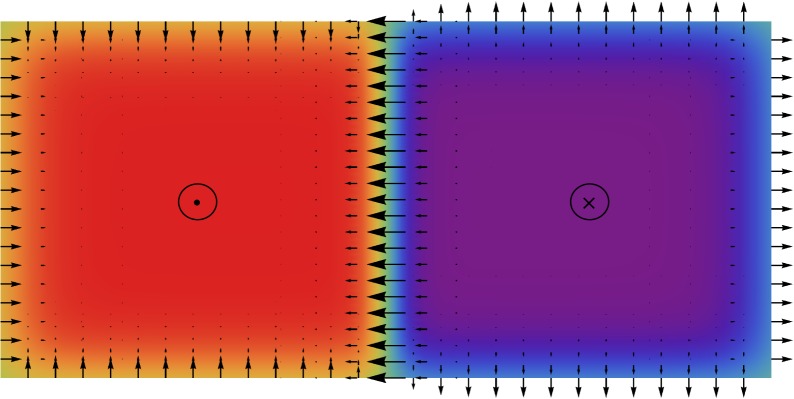
Schematics of a magnetization configuration containing edge walls and a Dzyaloshinskii wall. The arrows show the in-plane components of the magnetization vector, the colours correspond to the out-of-plane component (‘red’ is up, ‘violet’ is down, also indicated by up/down symbols). (Online version in colour.)